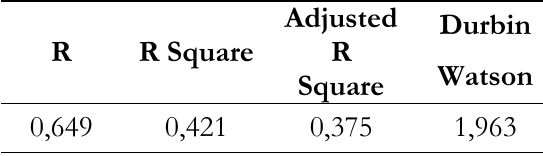
Figure 1. Scatterplot Graph Table 5. Autocorrelation Test